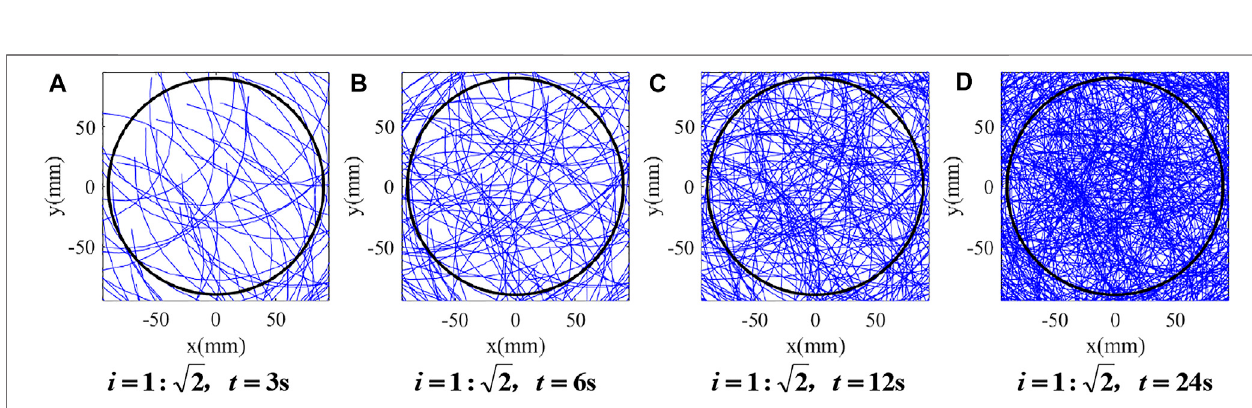
(cid:1)(cid:1) √ , t (cid:1) 12s. 2